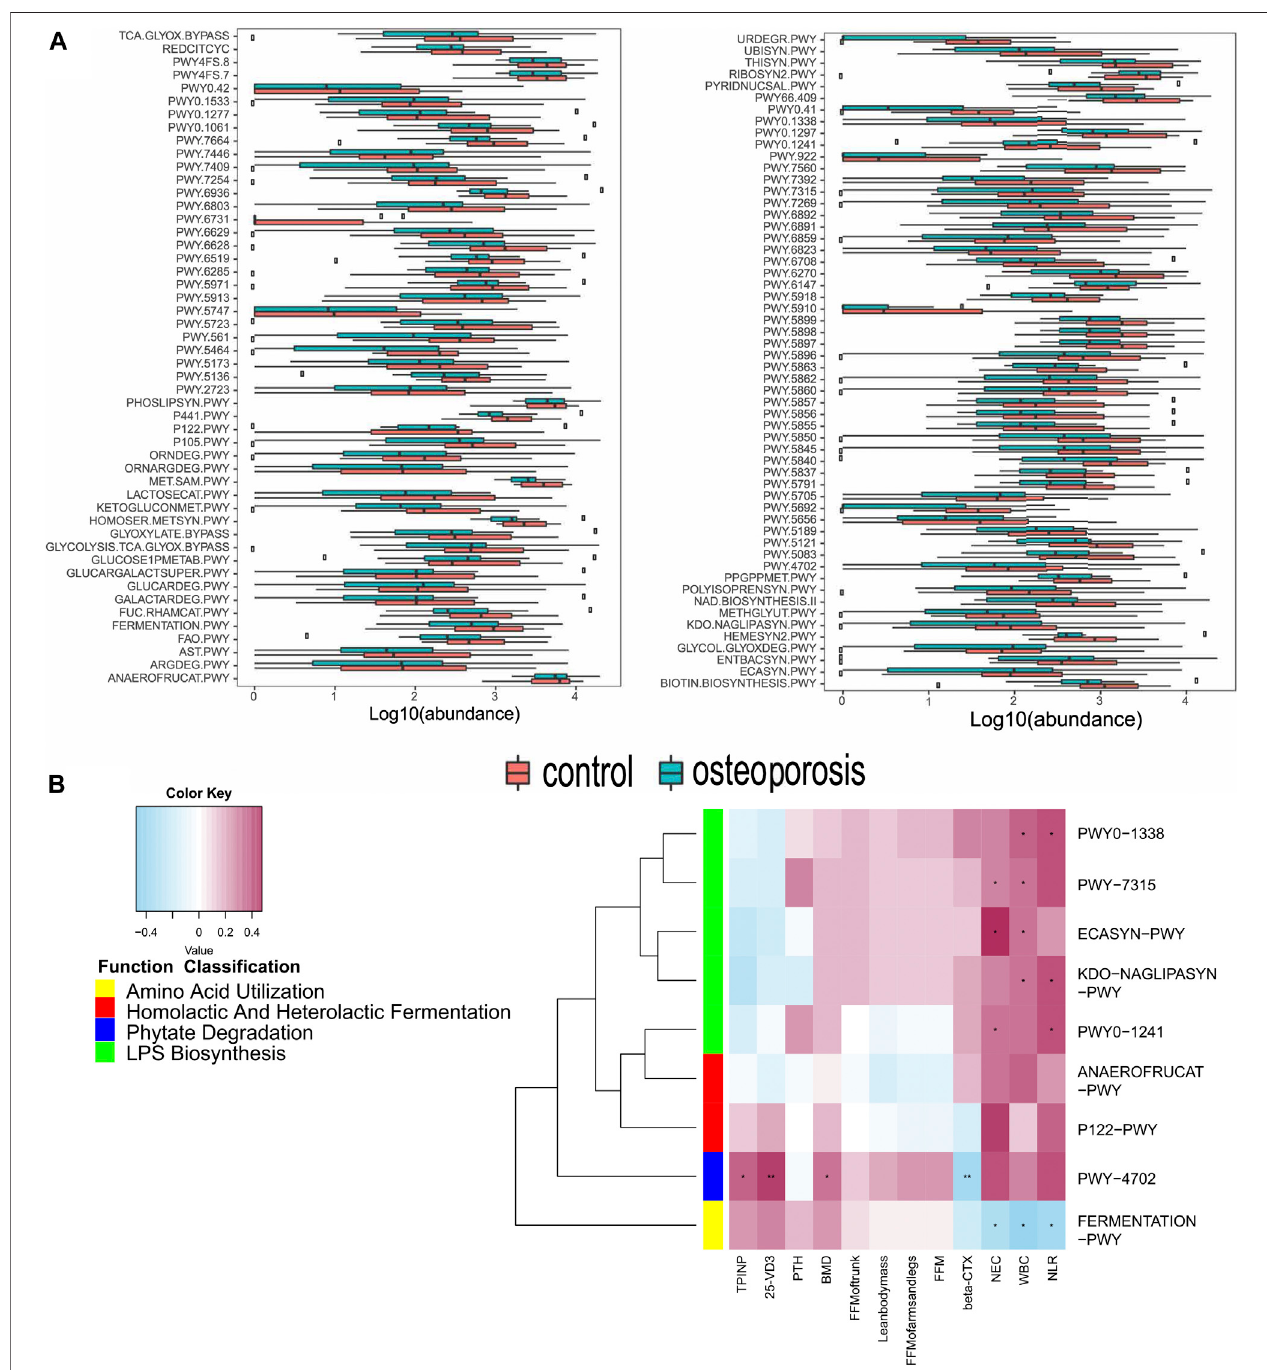
FIGURE 4 | Functional shifts in bacterial species between OP and control groups, and relationships between functional shifts and BMD or in fl ammation levels. (A) Functional shifts inbacterial species. MetaCyc pathways withdifferentabundances betweenhealthycontrolsand the OPgroups ( p < 0.05, Wilcoxon ranksum test). (B) Spearman ’ s correlation matrix for OP-correlated pathways and BMD measurements or in fl ammation levels. Blue signi fi es a negative correlation, while yellow and red signify a positive correlation. Cells with an asterisk indicate p < 0.05.